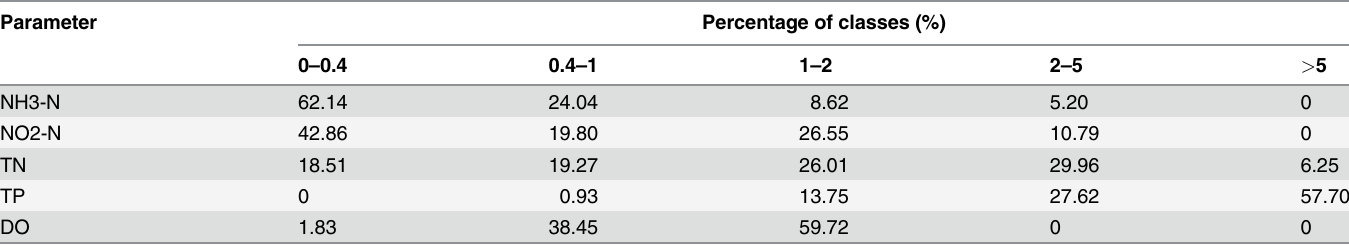
Table 6. GIS extracted coverage percentage of the study area for NH 3 -N, NO 2 -N, TN, TP and